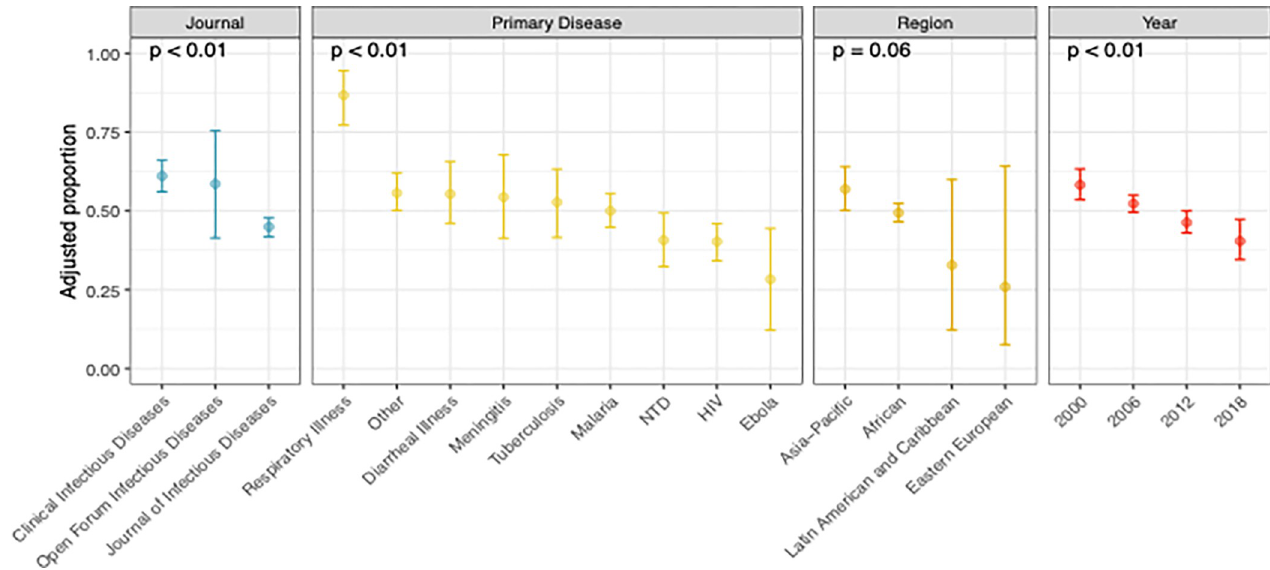
Fig 3. Adjusted proportion of first or last authors affiliated with low-income countries. Displayed as adjusted for year, journal, study topic and geographic region. Abbreviations: NTD, neglected tropical diseases; HIV, human immunodeficiency virus.